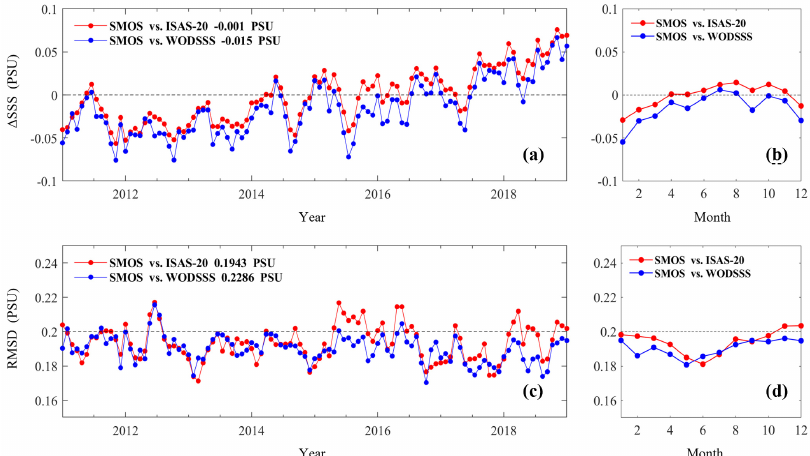
Figure 9. The long-term monthly ( a,c ) and seasonal ( b,d ) time series of ∆ SSS ( a,b ) and RMSD ( c,d ) with respect to WODSSS and ISAS-20 data between 60 ◦ S and 60 ◦ N after excluding areas of excessive